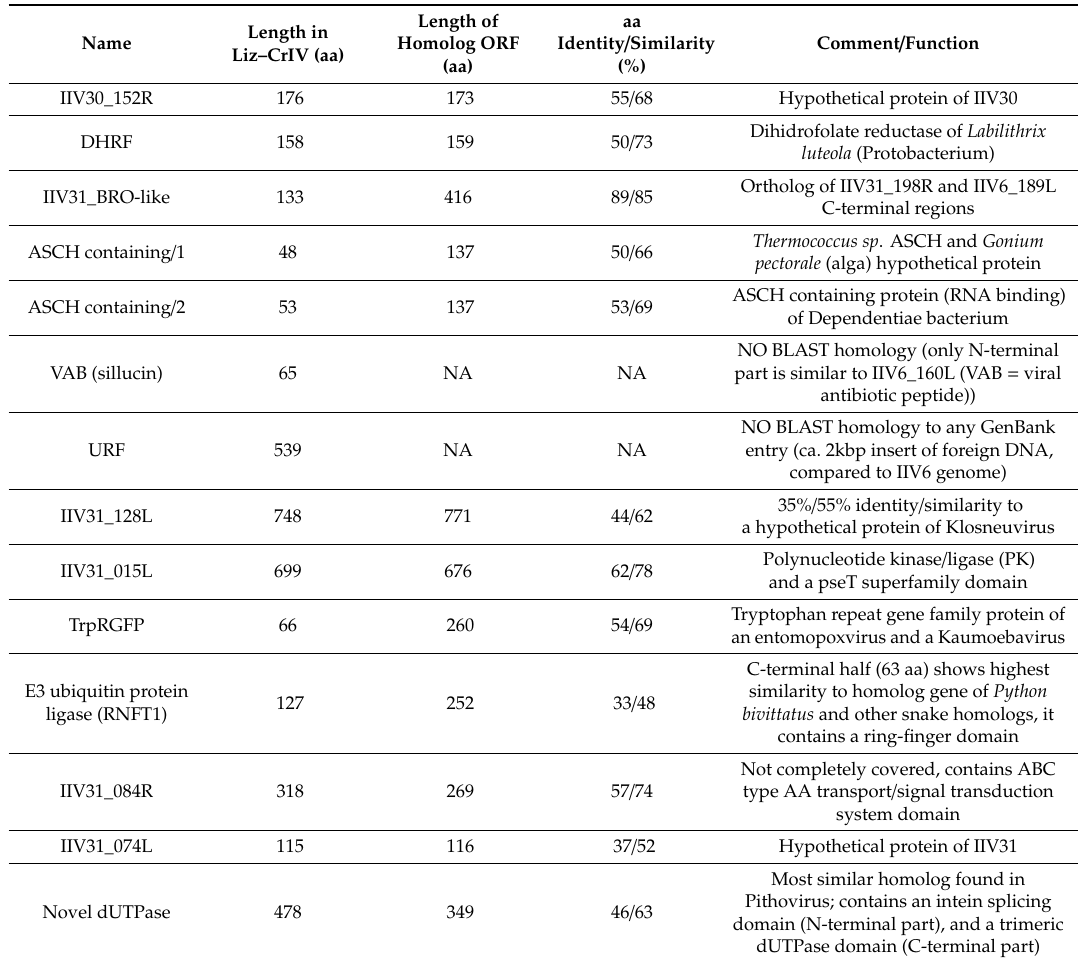
Table 2. Non-IIV6-like open reading frames (ORFs) in the chameleon IV sequence (names are according to those in Figure